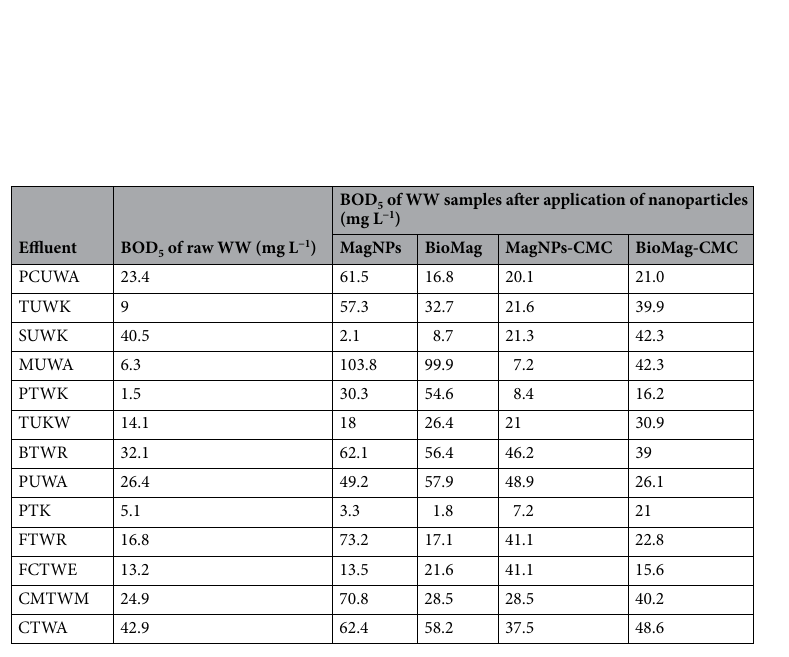
Table 3. Ranges of BOD analysis obtained before and after remediation for the 13 study